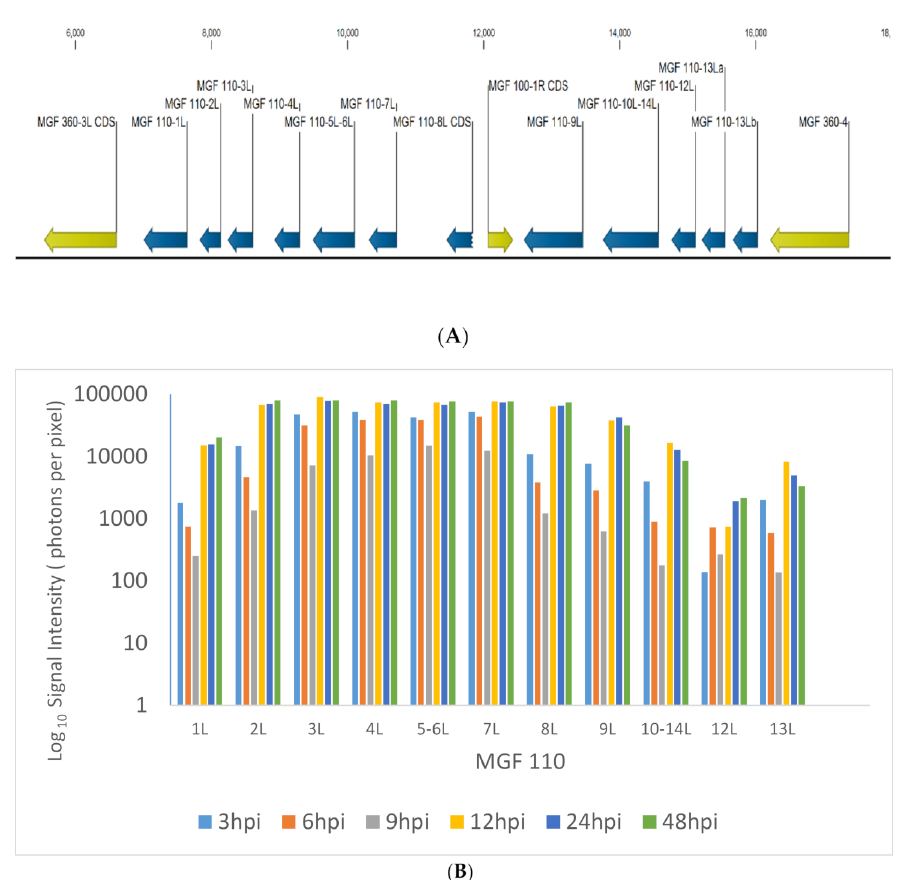
Figure 1. ( A ) Location and orientation of all MGF110 family of genes. The MGF110 genes are depicted in Blue. Other multi-gene family (MGF) genes within this region of the ASFV-G genome are depicted in yellow ( B ) Expression levels of individual MGF 110 genes at the indicated timepoints, expression is measured in Log 10 Signal